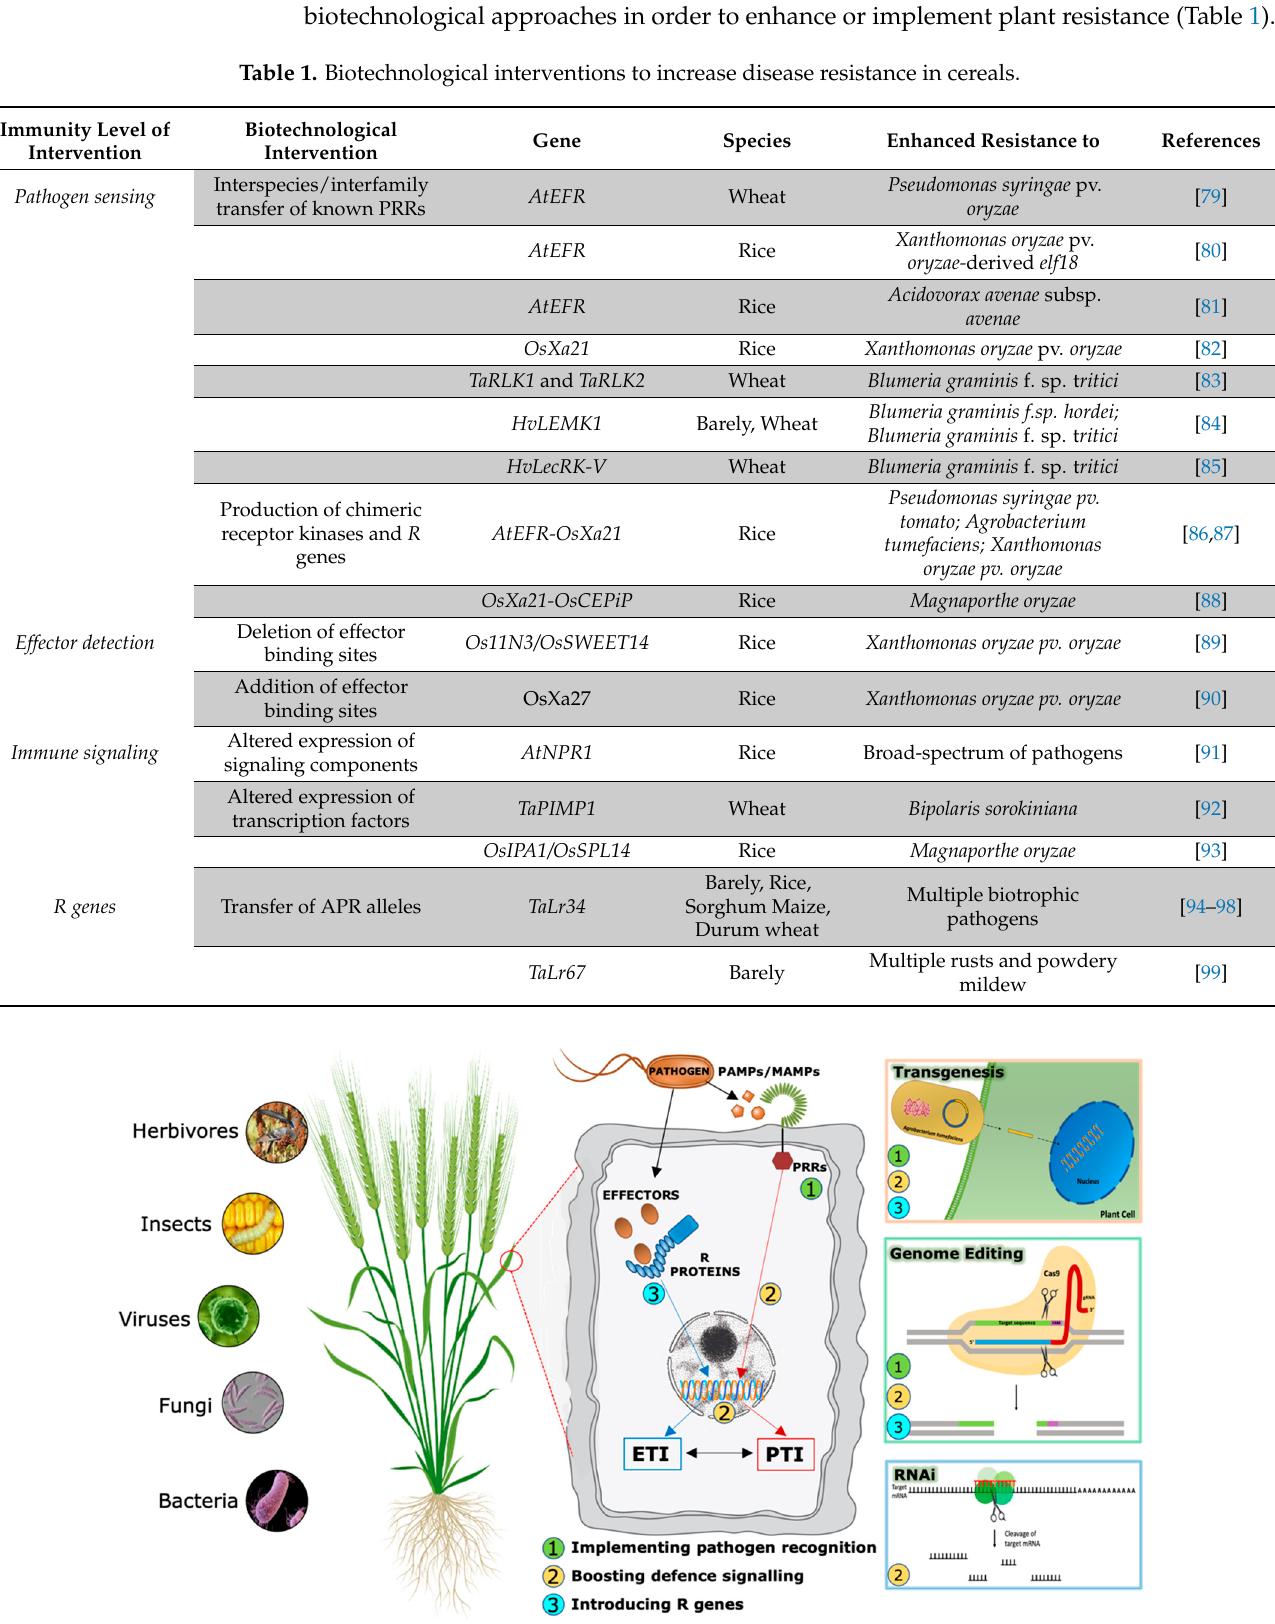
Figure 2. Biotechnological approaches and their possible involvement to enhance cereal resistance to pathogens. Indeed, the impact of RNAi technology deployed as a GM solution against viruses is clearly demonstrated in different studies [125–127]. Wheat dwarf virus (WDV) is a mem- ber of the Mastrevirus genus of the Geminiviridae family. This virus translates four viral proteins and causes economical losses in wheat and barley when it is transmitted to plants through leafhoppers. Kis et al. [126] targeted 13 different wheat- and barley-infecting WDV strains to identify conservative target sites and design miRNAs by using the miRNA precursor (hvu-MIR171) backbone of barley. They constructed a polycistronic artificial microRNA (amiRNA) precursor, which expresses three amiRNAs at the same time. As a result, transgenic barely plants that express amiRNAs at high levels presented no infection symptoms. Recently, RNAi has been explored as a strategy to also control fungi and oomycetes. Fungal target genes are obvious candidates for this approach, as disruption is known to be lethal. A biotechnological method, termed host-induced gene silencing (HIGS), has emerged as a promising alternative in plant protection because it combines high selectiv- ity for the target pathogen with minimal side effects, as compared with chemical treat- ments. Significant effects have been observed in transgenic Arabidopsis and barley ( Hordeum vulgare ) plants, expressing via HIGS a 791 nucleotide (nt) dsRNA (CYP3RNA) targeting all three CYP51 genes ( FgCYP51A , FgCYP51B , FgCYP51C ) of Fusarium gramine- arum ( Fg ) that led to the inhibition of fungal infection [128]. Cheng et al. [129] reported that the expression of RNAi sequences derived from an essential Fg virulence gene, the chitin synthase 3b ( Chs3b ), is an effective method to en- hance resistance of wheat plants against fungal pathogens. Three hairpin RNAi constructs corresponding to the different regions of Chs3b were found to silence Chs3b in Fg strains. Co-expression of these three RNAi constructs in two independent elite wheat cultivar transgenic lines conferred high levels of stable and consistent resistance (combined type I and II resistance) to both Fusarium Head Blight (FHB) and Fusarium Seedling Blight (FSB). A better understanding of this process in diverse plant-pathogen interactions may allow to better optimize HIGS strategies providing field-relevant levels of resistance [130– 132]. In short, RNAi appears to be a promising additional control strategy in the arsenal of plant breeders against at least some pathogens. The modular nature of RNAi is espe-